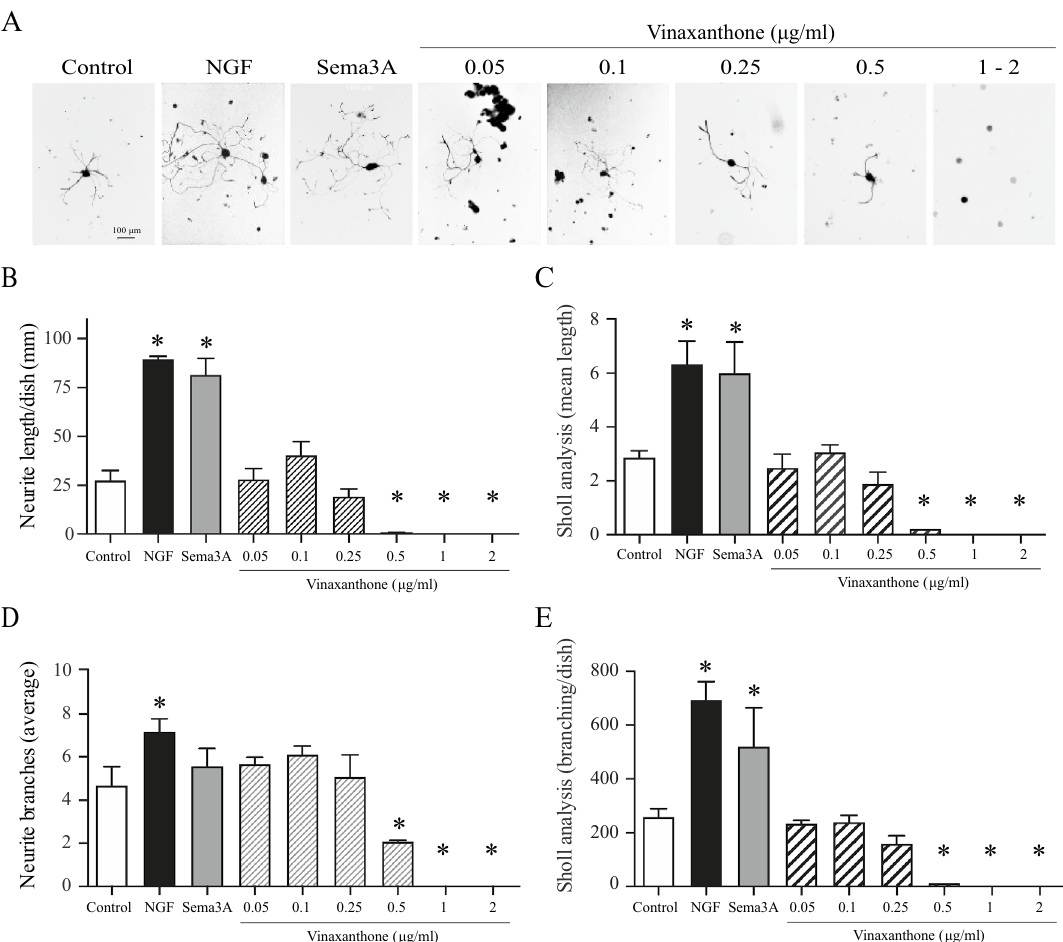
Figure 3. Effect of Vinaxanthone on neurite elongation and branching in adult TG neurons in the absence of growth factors. Isolated trigeminal neurons were left untreated or treated with either NGF or Sema3A at 50 ng/mL or with Vinaxanthone in a dose response manner. ( A ) Representative images of neurite elongation and branching observed after 3 days of culture with the indicated treatments. ( B , C ) Quantification of neurite length showed that NGF and Sema3A induced strong neurite outgrowth, while Vinaxanthone at a dose of 0.25 μg/mL or lower showed similar effects to control dishes. However, Vinaxanthone at a dose of 0.5 μg/mL or higher inhibited the formation of long neurites to a level below the untreated control condition. ( D ) Similar average neurite branching was observed among all treatments that presented elongated neurons. ( E )